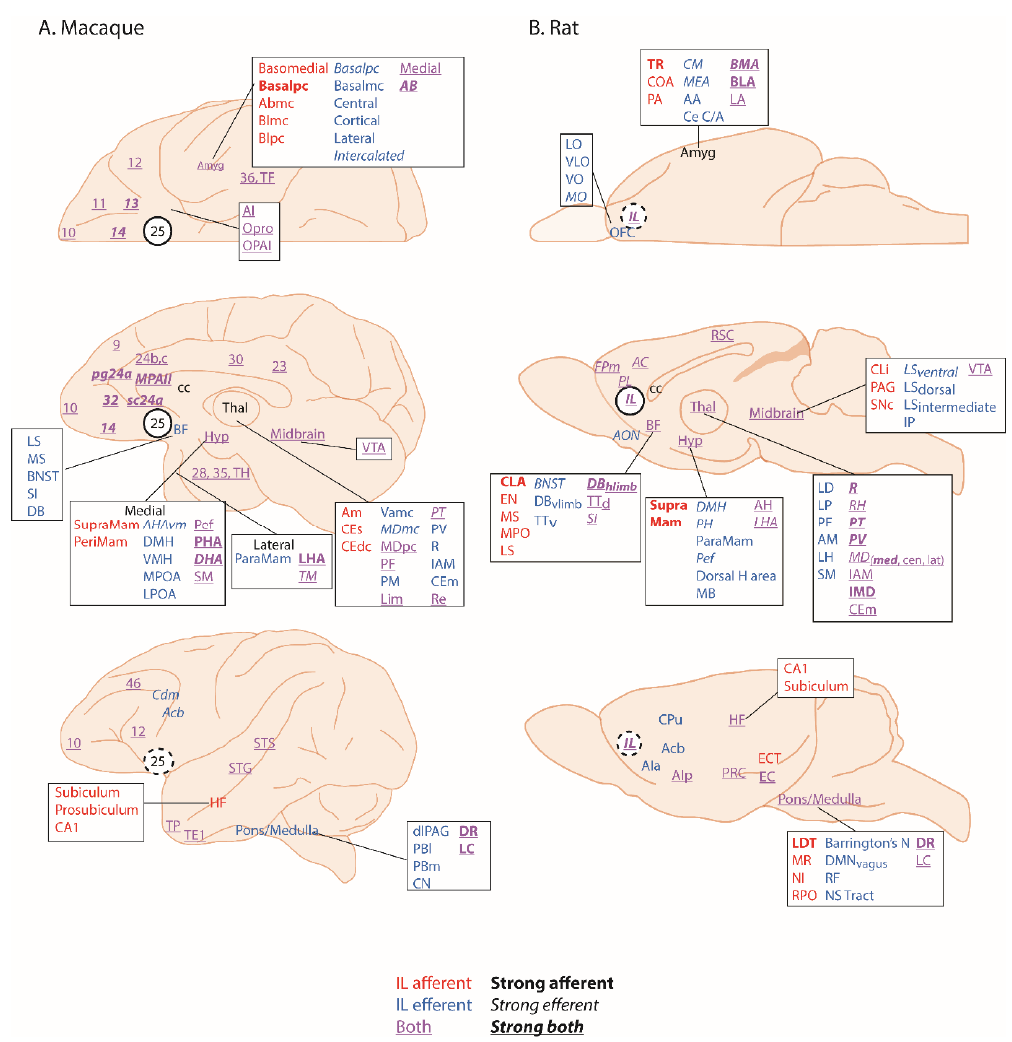
Figure 1. The connectivity of area 25 in macaques and the infralimbic cortex (IL) in rodents. In the macaque ( A ) area 25 has widespread efferent and afferent connections with many cortical and subcortical regions that are comparable to the efferent and afferent connections of IL in the rat ( B ). Afferents